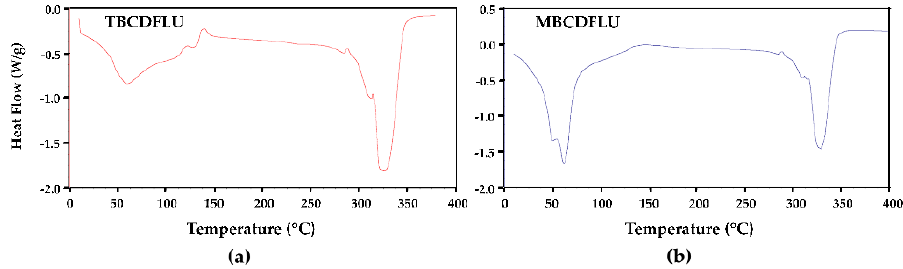
Figure 2. DSC traces for the β -CD ⋅ fluconazole complexes, (a) TBCDFLU and (b) MBCDFLU.